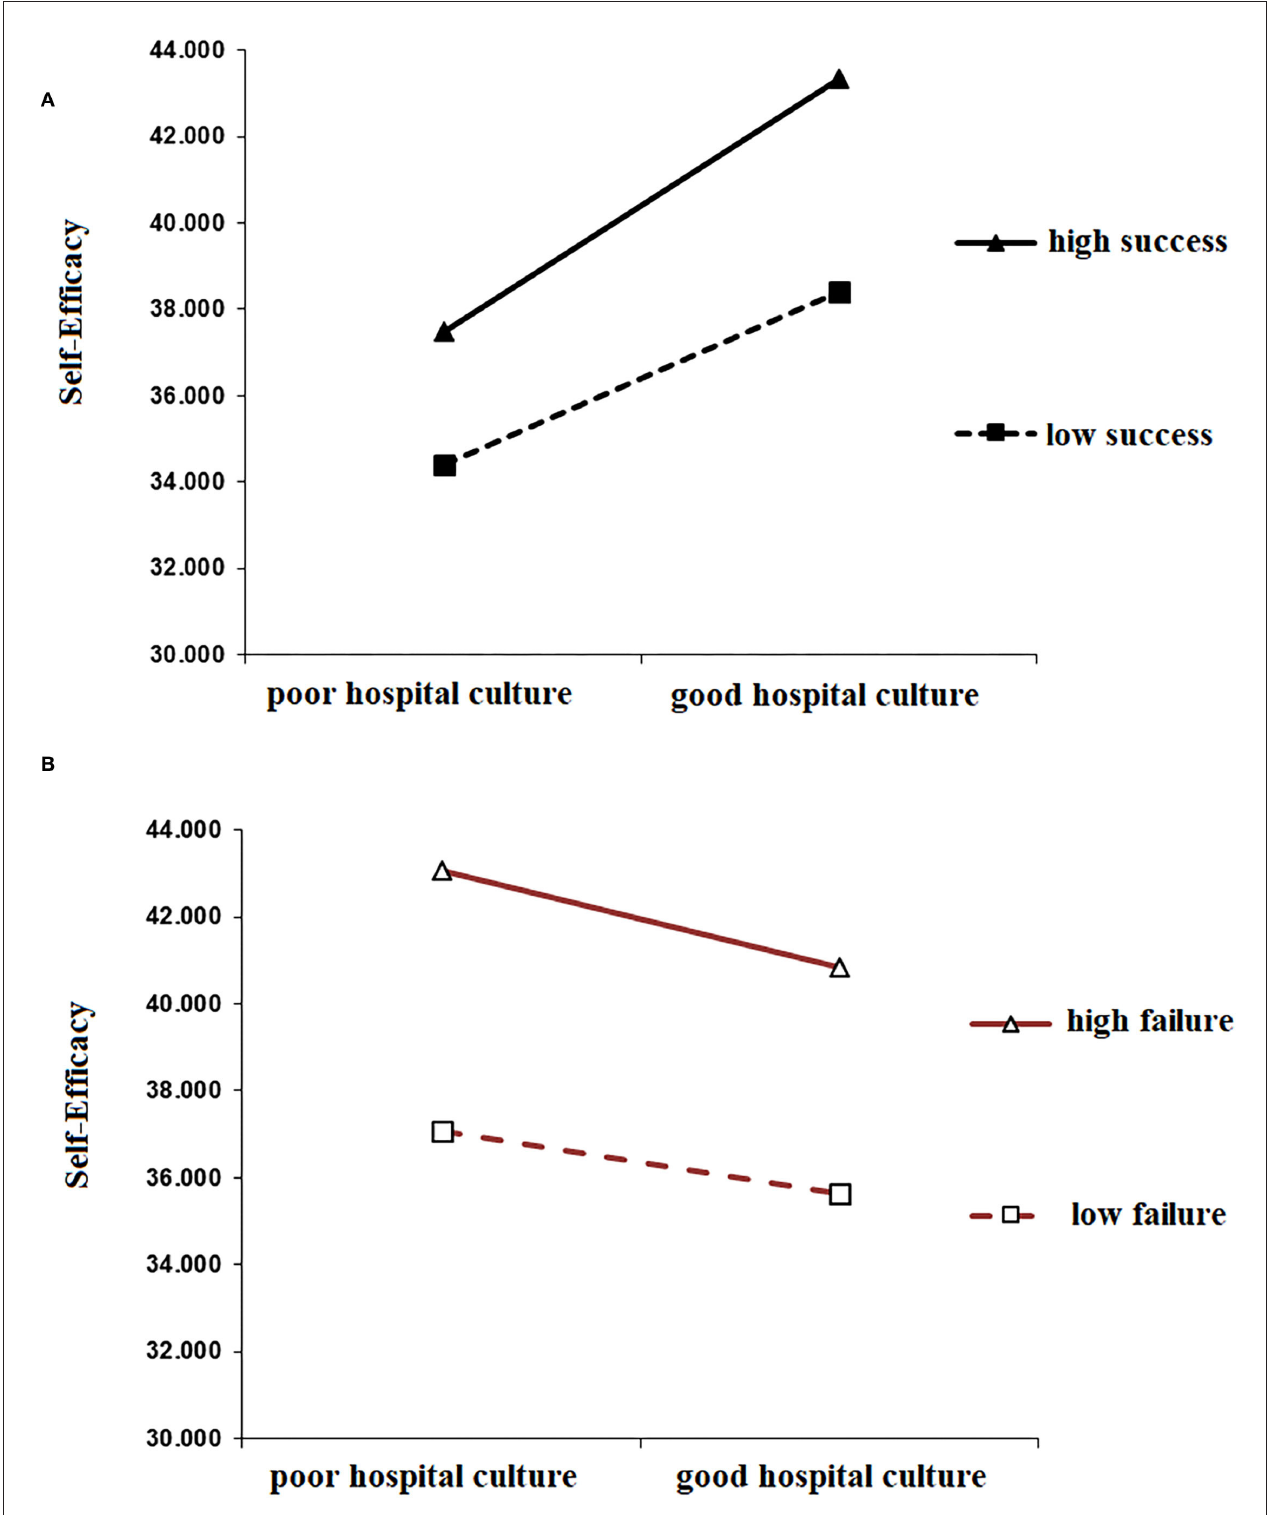
FIGURE 2 | (A) Moderating effect of the pursuit of success in the relationship between hospital culture and healthcare workers’ self-efficacy. (B) Moderating effect of the avoidance of failure in the relationship between hospital culture and healthcare workers’ self-efficacy.